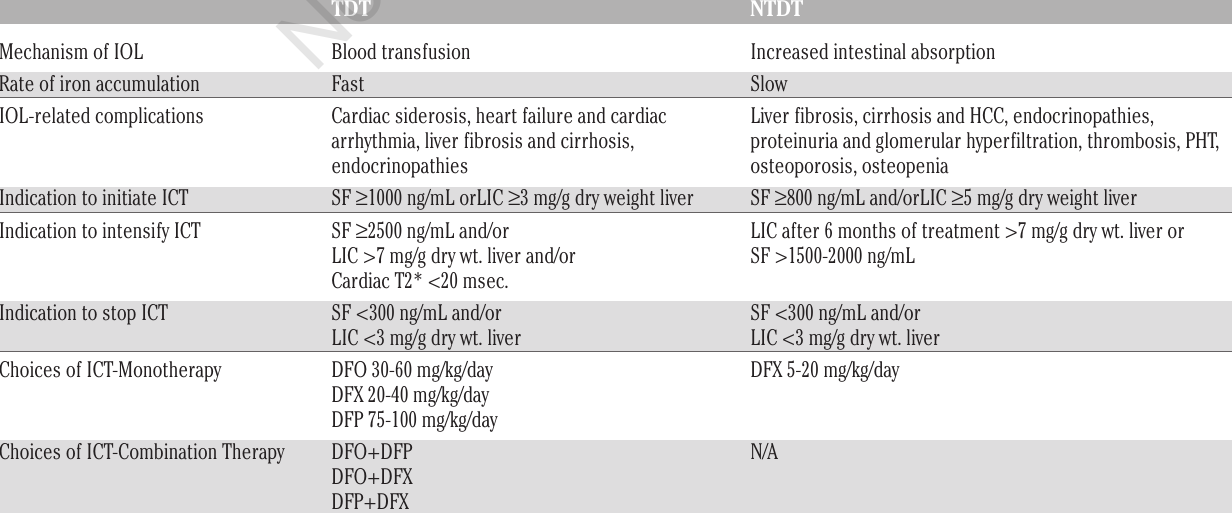
Table 2. Iron overload characteristics and iron chelation therapy indications in transfusion dependent thalassemia vs non-transfusion dependent thalassemia [78].